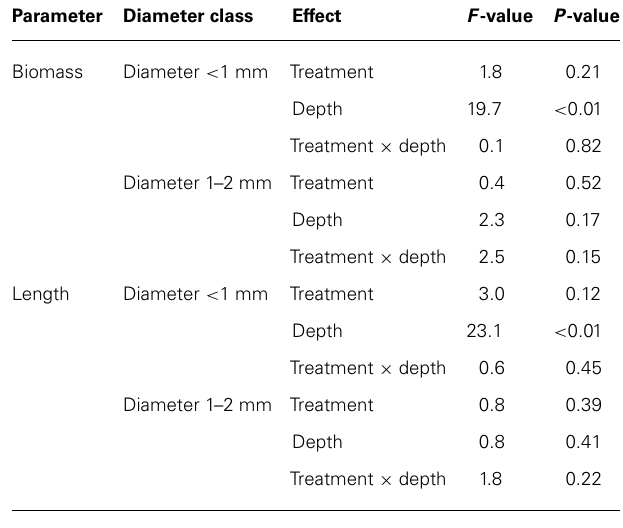
Table 4 | Results of split-plotANOVA examined for effects of N fertilization (treatment) and soil depth (depth) on biomass and length of fine roots.